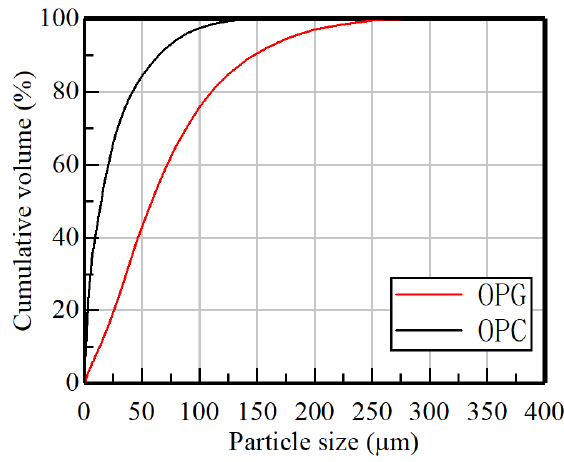
Figure 2. Particle size distribution of OPG and OPC.